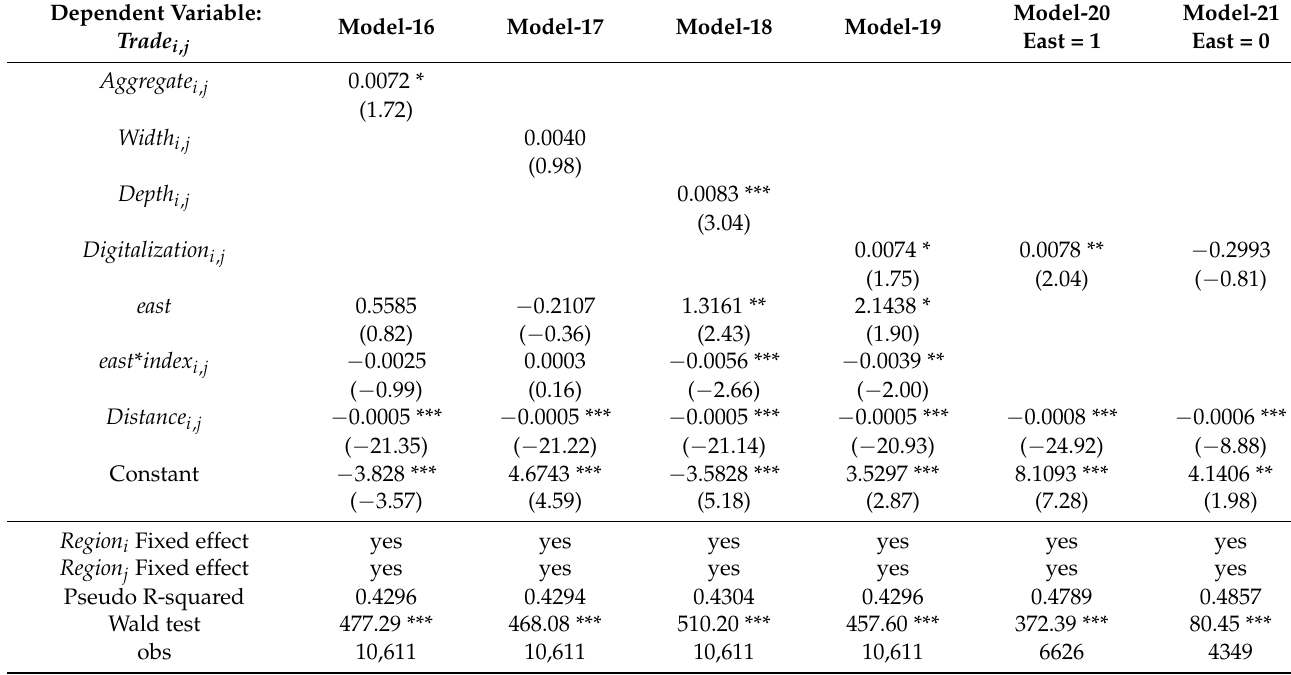
Table 6. Results of regional heterogeneity estimated by the PPLM-FE model.